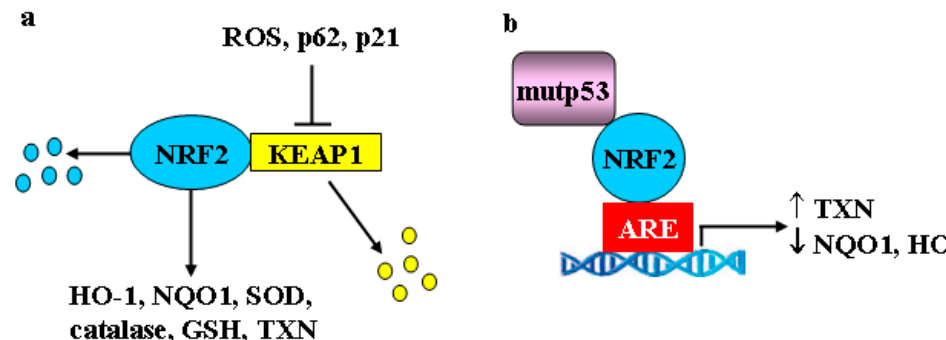
Figure 3. Mutant p53 and the NRF2 signaling. ( a ) NRF2 undergoes protein degradation following interaction with KEAP1 that can be released by oxidative stress and reactive oxygen species (ROS) generation or by p62- and p21-induced noncanonical KEAP1 degradation. ( b ) Mutp53 may interact with NRF2 and bind the antioxidant response elements (ARE) of target genes and differentially modulate NRF2 transcriptional activity, increasing thioredoxin (TXN) and reducing NAD(P)H:quinone oxidoreductase 1 (NQO1) and heme oxygenase 1 (HO-1) expression.